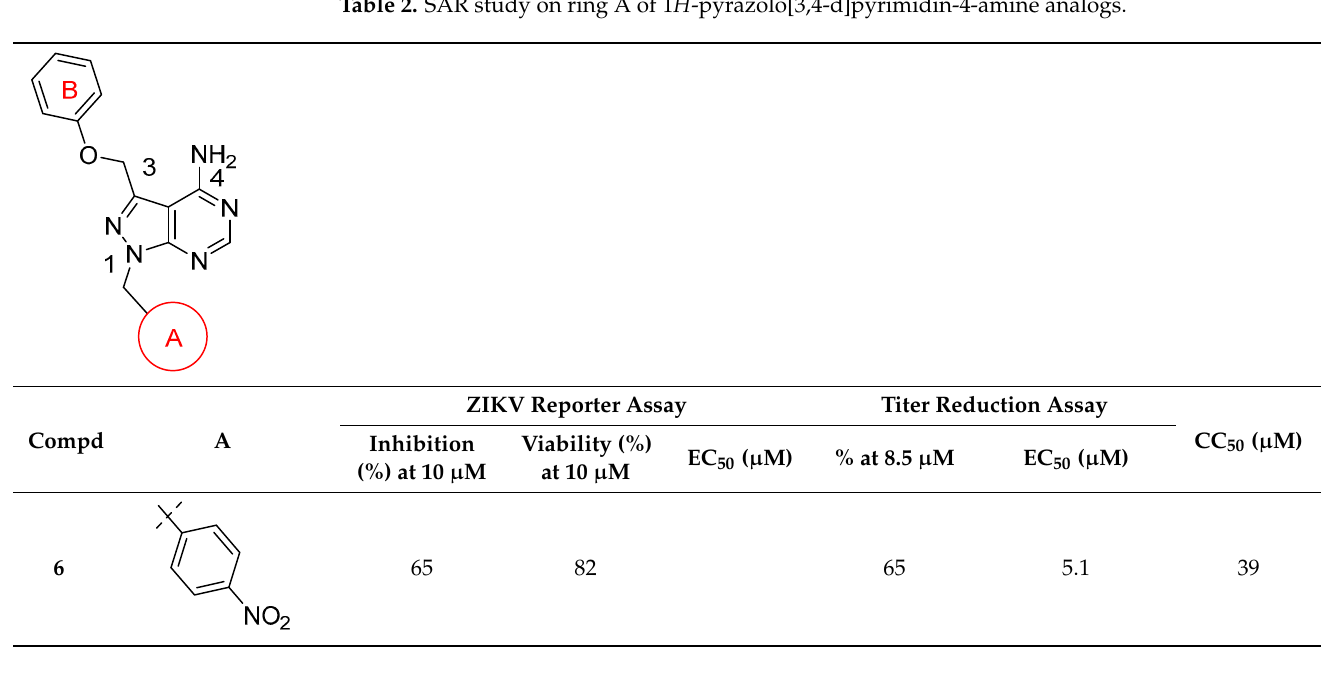
Table 2. SAR study on ring A of 1 H ‐ pyrazolo[3,4 ‐ d]pyrimidin ‐ 4 ‐ amine analogs.